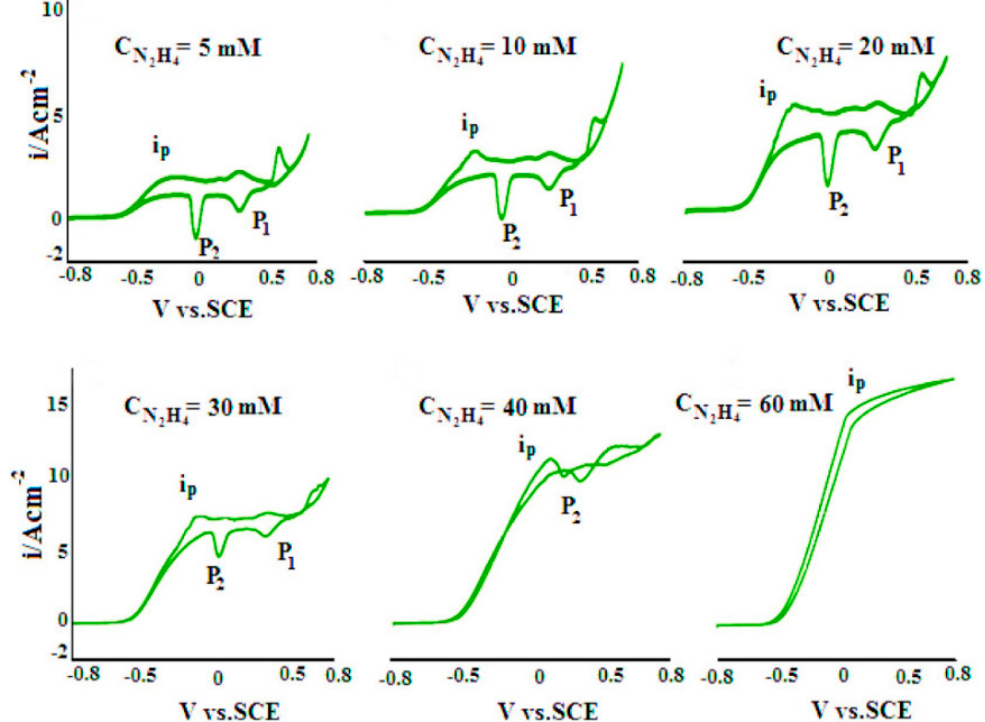
Figure 23. CV responses of the FTO/PANI-gC 3 N 4 /AgNP electrode at a scan rate of 50 mV in the presence of different hydrazine concentrations. Modified with permission from [254]. Copyright 2018 Elsevier.